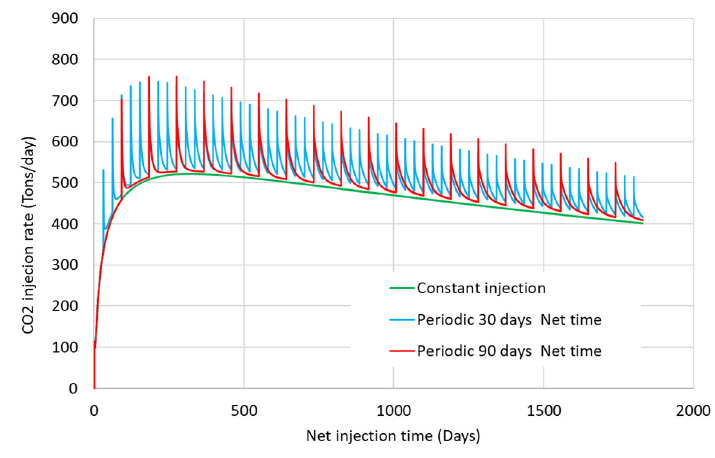
Figure 17. Net time rates of periodic injection vs. continuous injection rates for up-flank injection— clearly indicating rate improvements after each shut-in period.